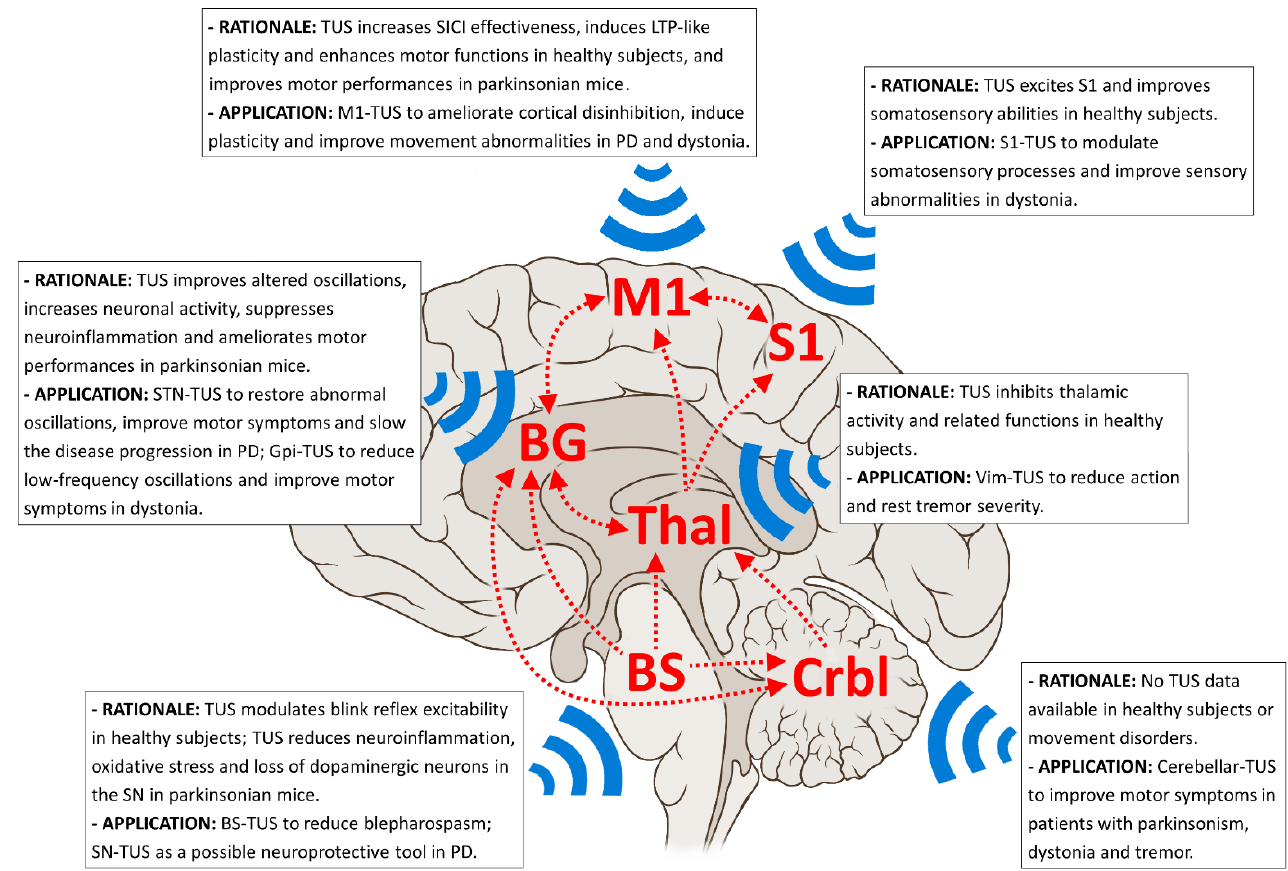
Figure 1. Most relevant nodes (red text) and pathways (red arrows) of the pathophysiological net- works involved in Parkinson’s disease (PD), dystonia and tremor syndromes, including essential tremor (ET). The boxes summarize the rationale and proposed applications for possible neuromod- ulation using TUS in these movement disorders patients. BG: basal ganglia; BS: brainstem; Crbl: cerebellum; LTP: long-term potentiation; M1: primary motor cortex; S1: somatosensory motor cortex; SN: substantia nigra; STN: subthalamic nucleus; Thal: thalamus; Vim: ventral intermediate nucleus.